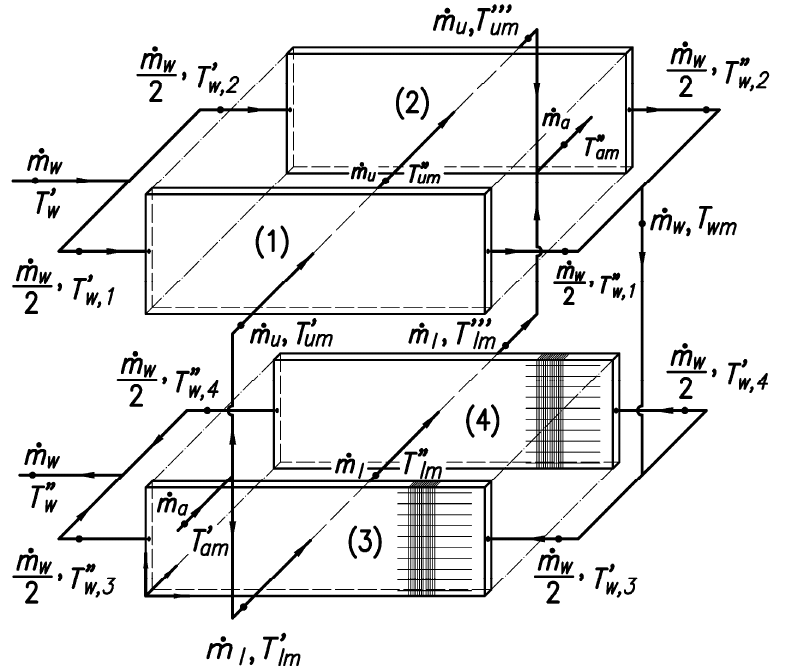
Figure 1. Flow arrangement of the car radiator analysed in the study: the two-pass car radiator with two rows of tubes consists of the first tube row in the first pass (1), second tube row in the first pass (2), first tube row in the second pass (3), and second tube row in the second pass (4). The flow rate of the water m to the engine cooler is divided into two equal parts / 2 through both rows of pipes in the first pass. The starting point for building a mathematical model of an engine cooler is a single-pass of the double-row PFTHE (first pass in the two-pass PFTHE with two tube rows) (Figure